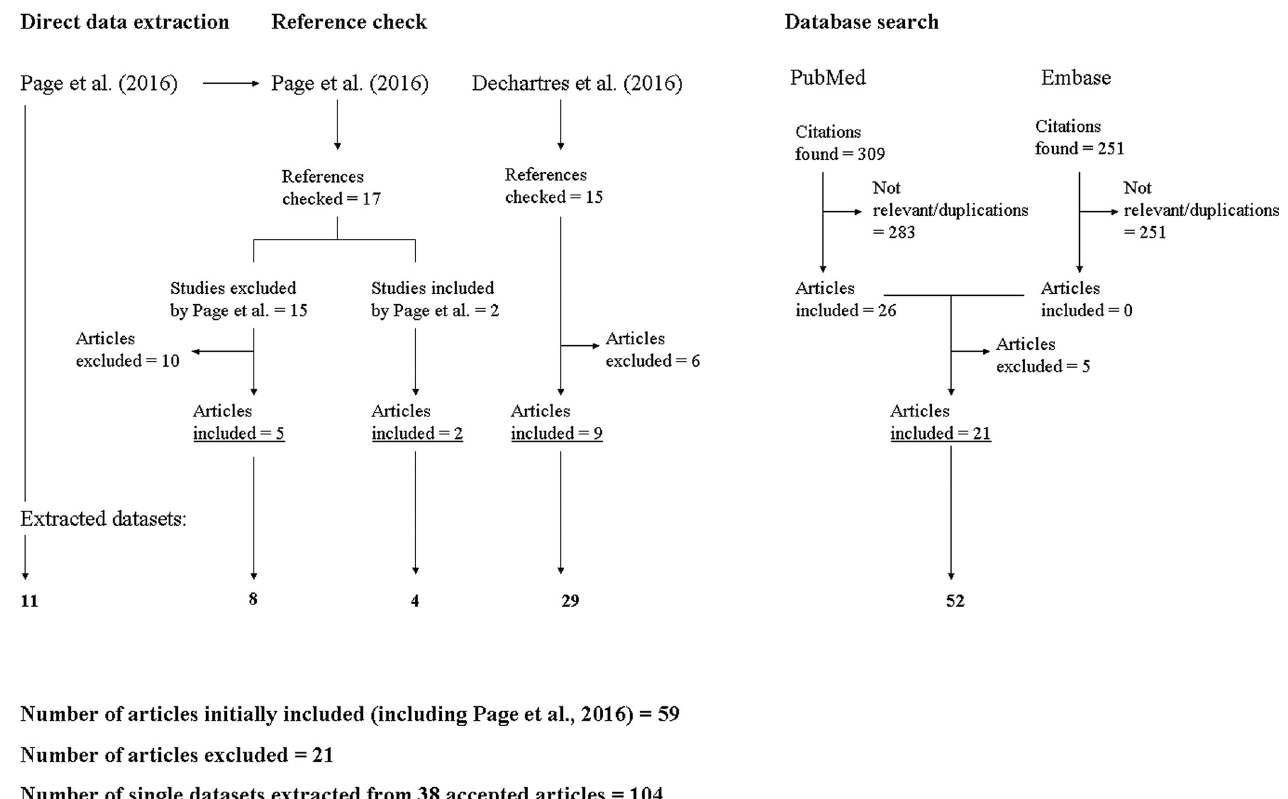
Fig 1. Flow diagram of identification, screening and inclusion of articles and